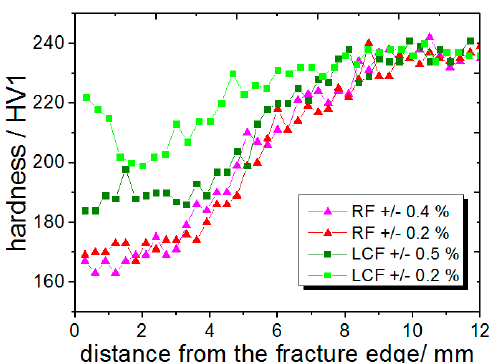
Figure 21. Hardness profiles measured on longitudinal gauge sections of specimens from different LCF- and RF-tests.